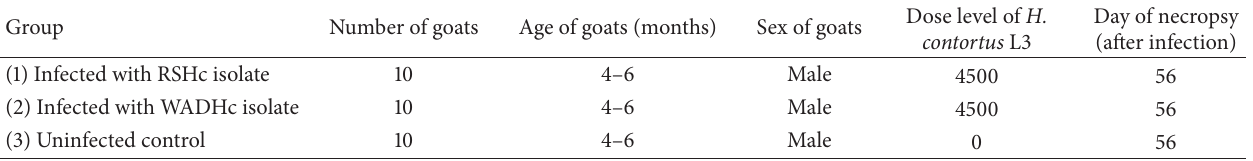
Table 1: Experimental